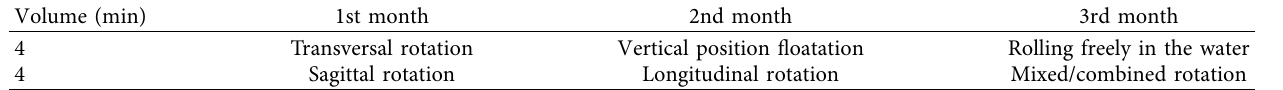
Table 2: Phase of familiarization with the liquid environment.